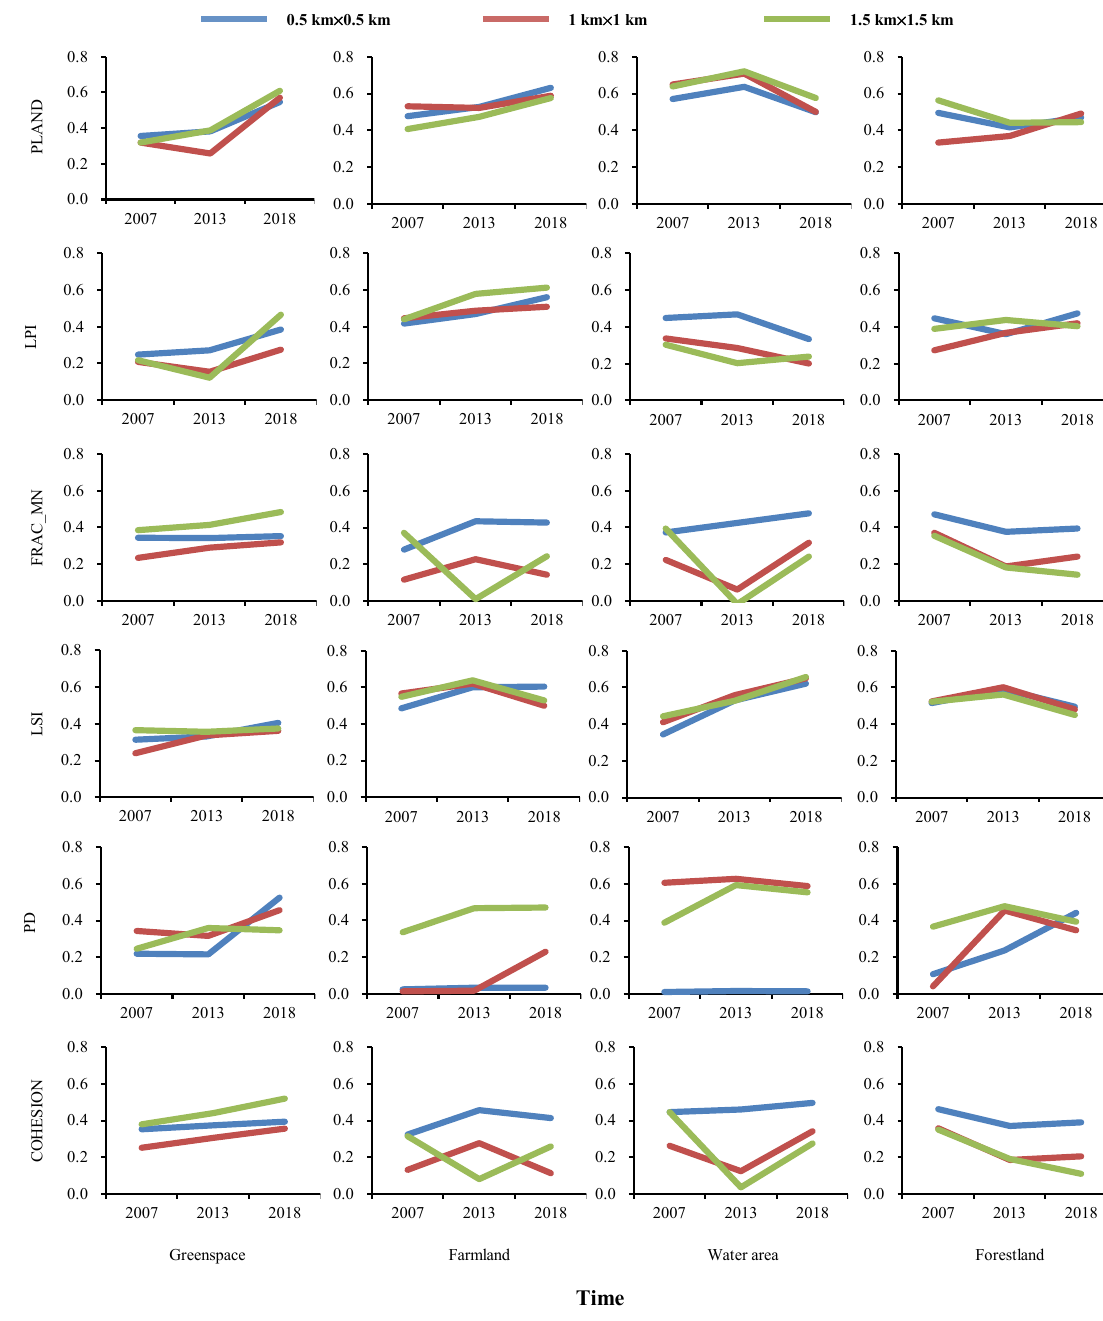
Figure 4. Global Moran’s I of landscape pattern indices.